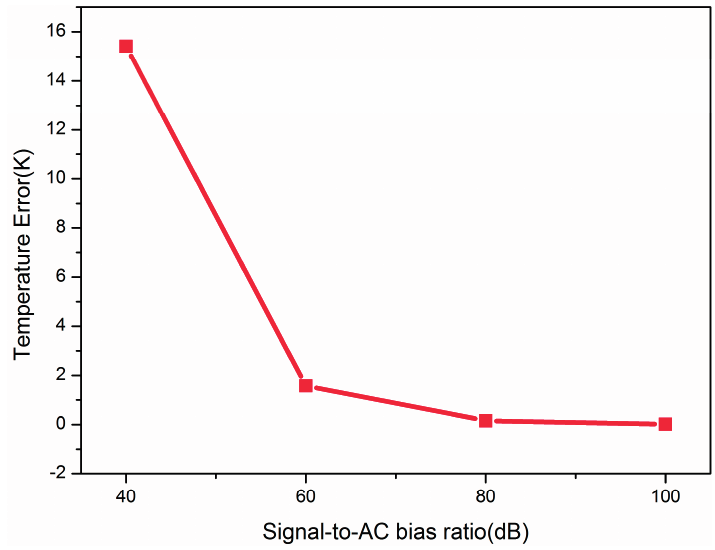
Figure 9. Temperature error caused by the AC bias under different signal-to-AC bias ratios (40, 60, 80, 100